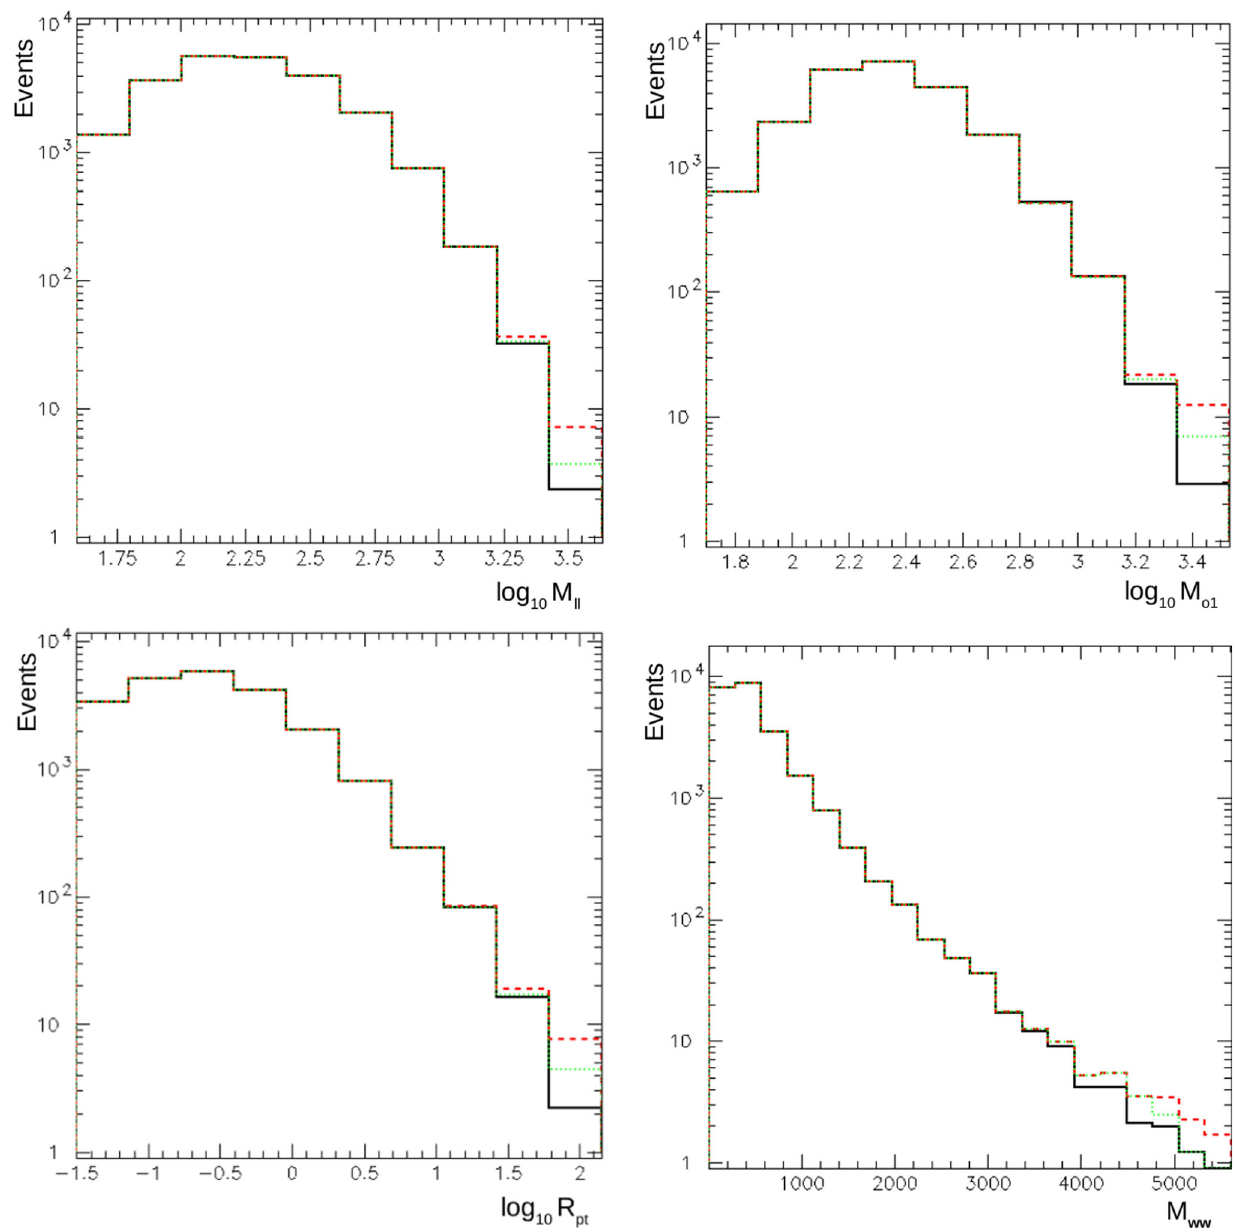
Fig. 1 Typicalexamples of kinematicdistributions used for the assess- ment of BSM signal significances. Shown are the distributions of M ll , M o 1 and R pT (in log scale): in the Standard Model (black), with f M 1 = 0 . 2 TeV − 4 and the high- M WW tail treatment according to Eq. (2.3) (red), and with f M 1 = 0 . 2 TeV − 4 and the high- M WW tail